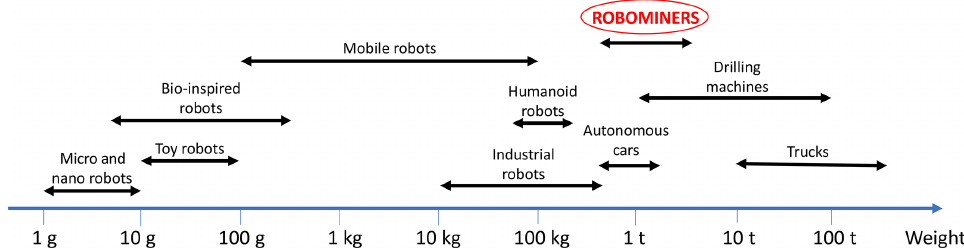
Figure 2. Weight comparison of different robotic systems and mining equipment. The robot-miner lies in the 1t range, heavier than most usual robots, but lighter than the conventional mining equipment currently used.